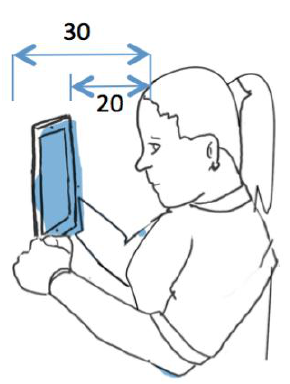
Figure 2. Suitable user-iPad position.